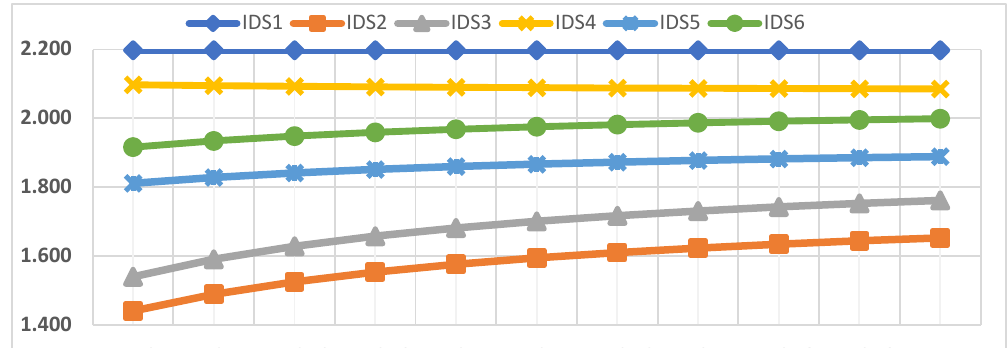
Figure 11. Closeness coefficient values of the IDSs in terms of the different values of Ѱ .